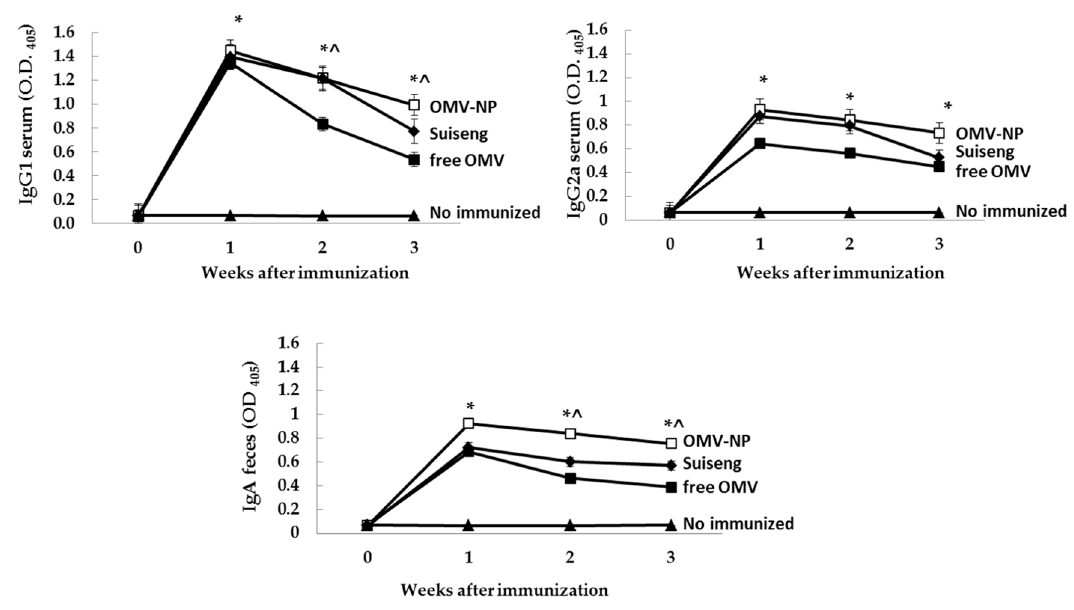
Figure 5. Antibody immune response induced after immunization of pregnant BALB / c mice. Two-week-pregnant BALB / c mice were immunized orally with a single dose of OMV (0.2 mg) either free or encapsulated into nanoparticles (OMV-NP) or intraperitoneally with the commercial vaccines (Suiseng ® , Lab. Hipra). PBS was used as control. Serum or fecal samples were diluted 1:100 or 1:20, respectively, in PBS. The results are shown as the mean levels for triplicates ± SD (* p < 0.05 for immunized mice vs. control; ^ p < 0.05 OMV-NP vs. free OMV). Production of IL-6, IL-10 and TNF α by splenocytes restimulated with OMV in vitro was determined at day 28 post-immunization (Figure 6). Results indicated that the encapsulation of OMV into zein nanoparticles induced an increase of IL-10 and TNF α cytokines, similar to the levels induced by the commercial vaccine, and significantly higher than the free OMV immunized group.